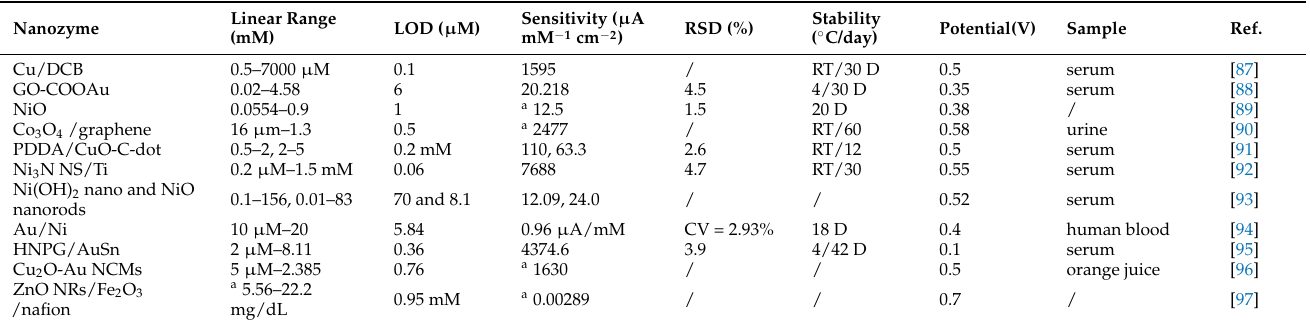
Table 3. Summary of amperometric sensors using nanozymes for the detection of glucose (LOD: limit of detection; RSD: relative standard deviation; a data have been normalized by us; /: not reported; CV: coefficient of